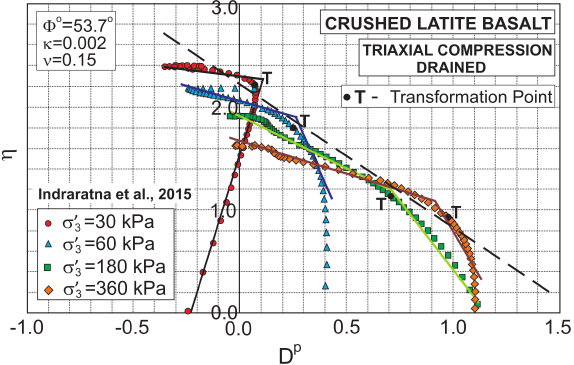
Figure 4: The relationships η-D p for crushed latite